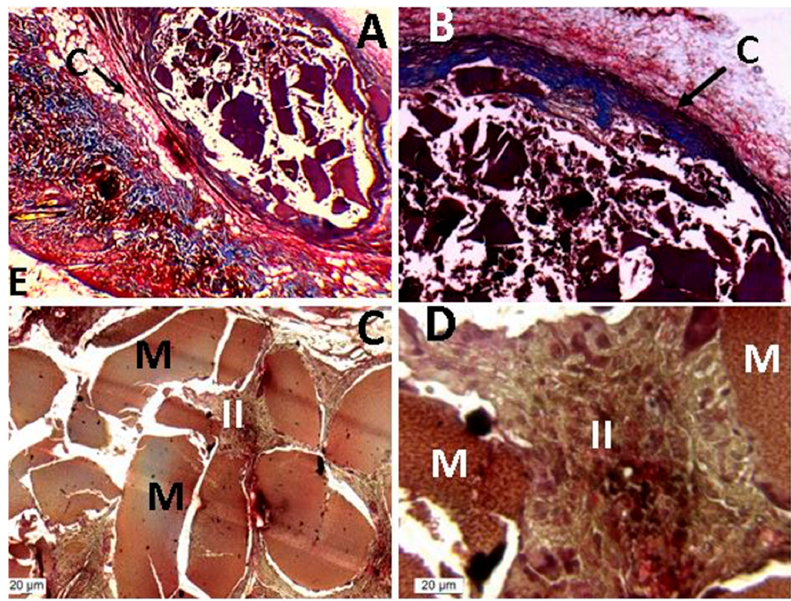
Figure 11. Histological analysis of experimental sample F3 (29.50 CS/70 PVA/0.50 ox-CNO. Magnifications are as follows: ( A ) 4×; ( B ) 10×; ( C ) 10×; ( D ) 40×. E: epidermis; D: dermis; H: hypodermis; C: capsule; IZ: implantation zone; M: material; II: inflammatory infiltrate. ( A , B ) correspond to sample F3 stained using hematoxylin and eosin. ( C , D ) correspond to sample F2 stained using Masson’s trichromacy.